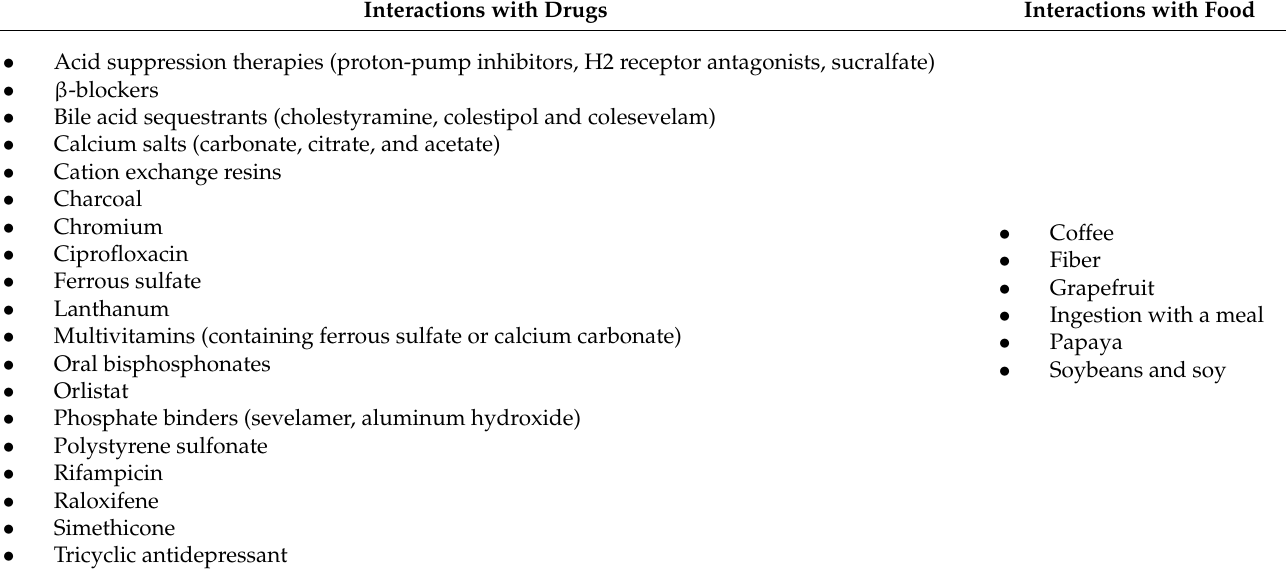
Table 2. Impact of drug and food on levothyroxine absorption [5,26]. Interactions with Drugs Interactions with